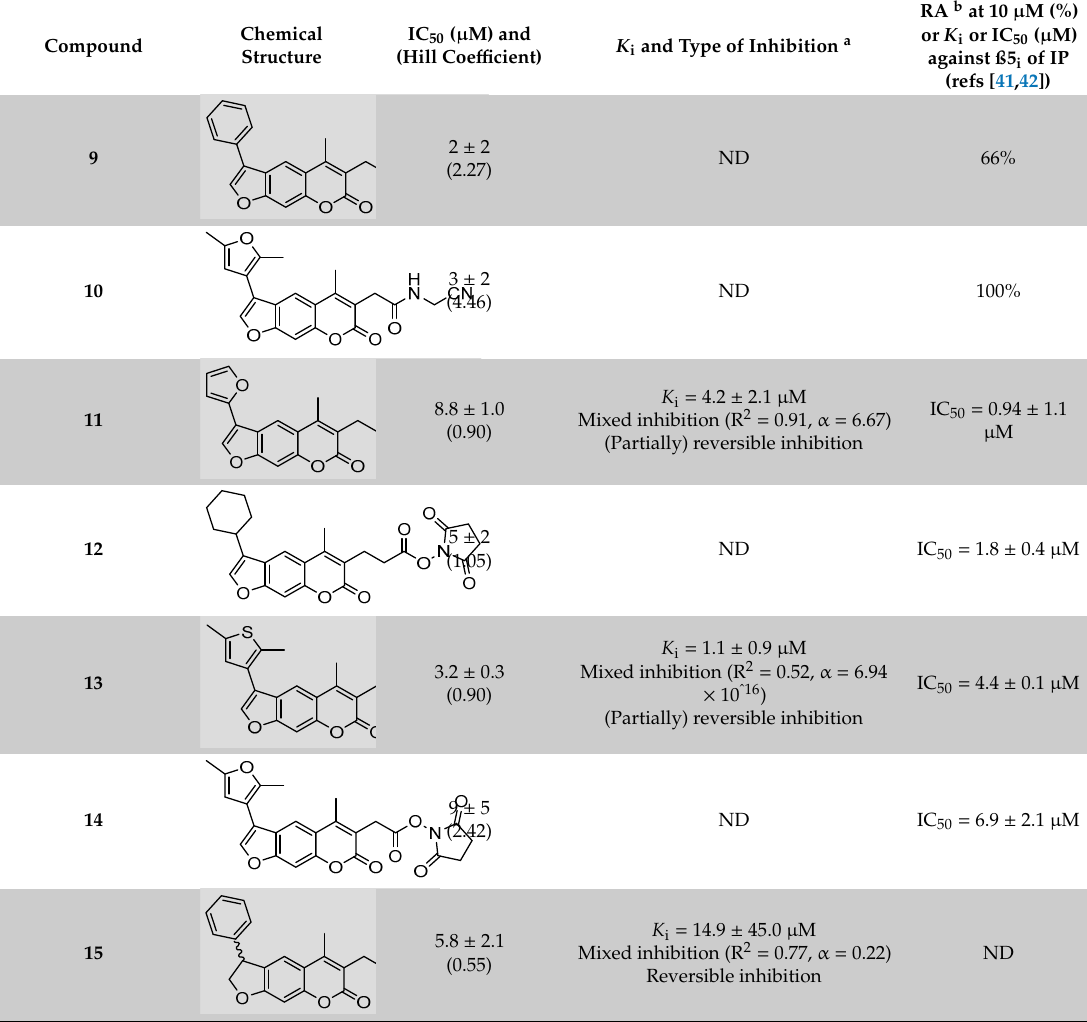
Figure 4. The summary of the SAR study of psoralen derivatives targeting the Mtb proteasome. 2. Results and Discussion Following the characteristics of some psoralen derivatives that selectively target the β 5i subunit of human IP, we decided to explore the potential of this chemical class to inhibit the Mtb proteasome. Due to structural similarities between the IP and the Mtb proteasome, activity against the mycobacterial proteasome from psoralens would be expected. In this SAR study (Figure 4), we